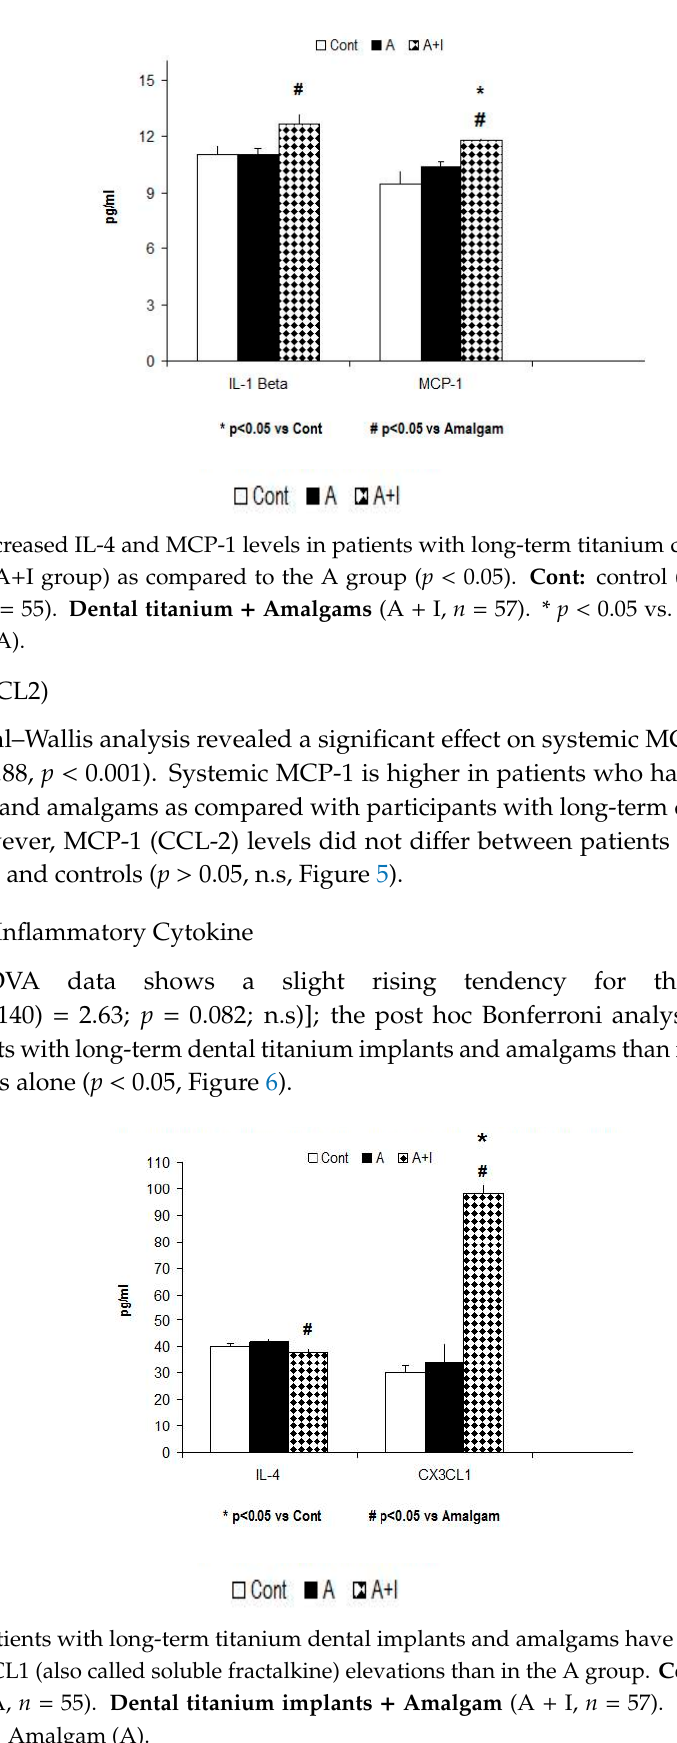
Figure 6. Patients with long-term titanium dental implants and amalgams have lower IL-4 levels